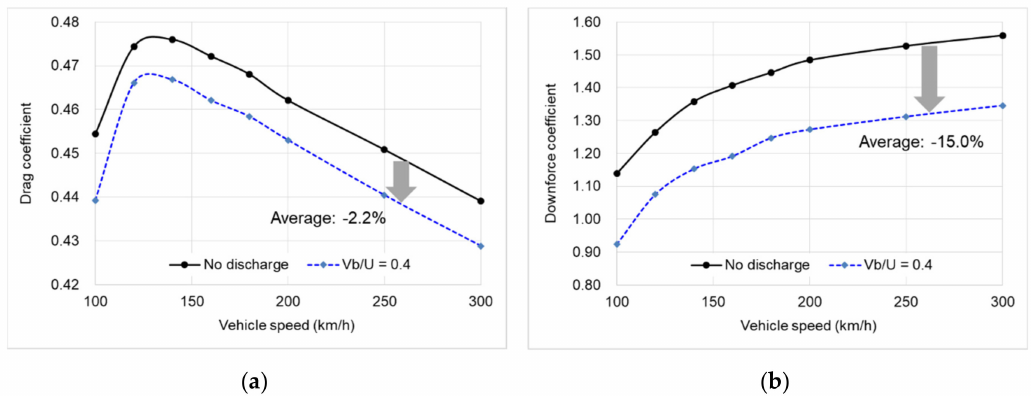
Figure 13. Comparison of aerodynamic coe ffi cients when flow is discharged at 0.50C; ( a ) Aerodynamic drag; ( b ) Downforce coe ffi cient.